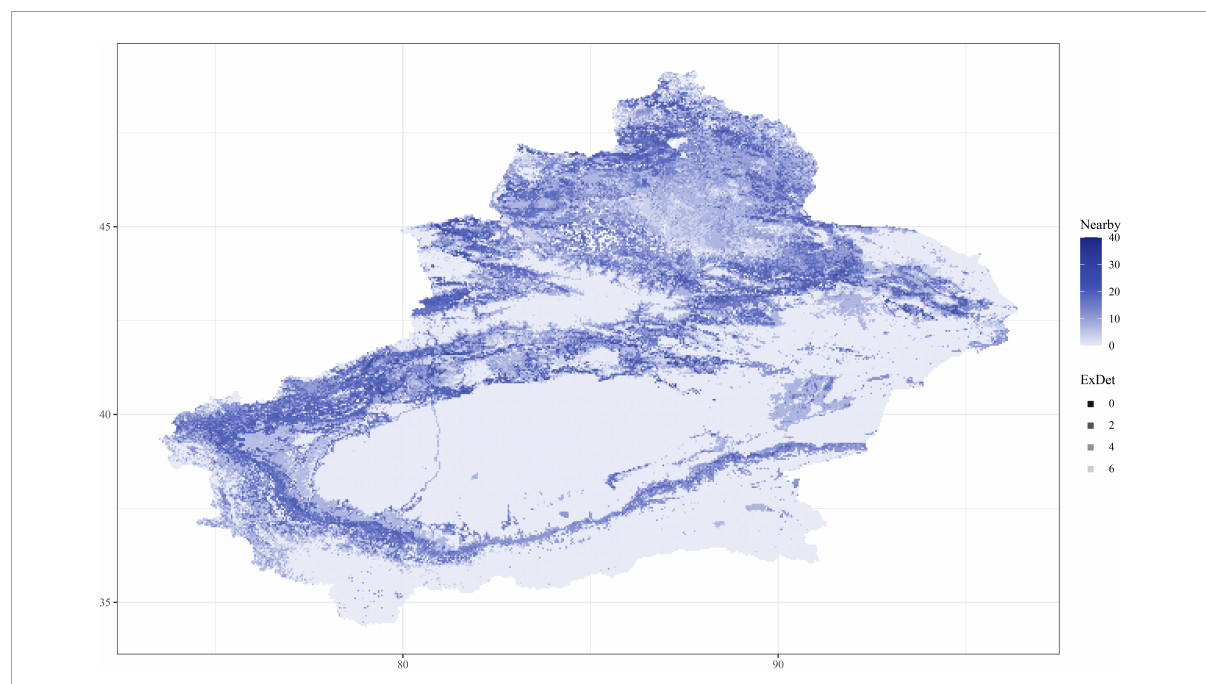
FIGURE4 The uncertainty of C. salsa prediction. ExDet is the extrapolation detection metric, and Nearby is the percentage of data nearby (%N). When the color is deeper, the areas are more reliable (with high%N and low ExDet).